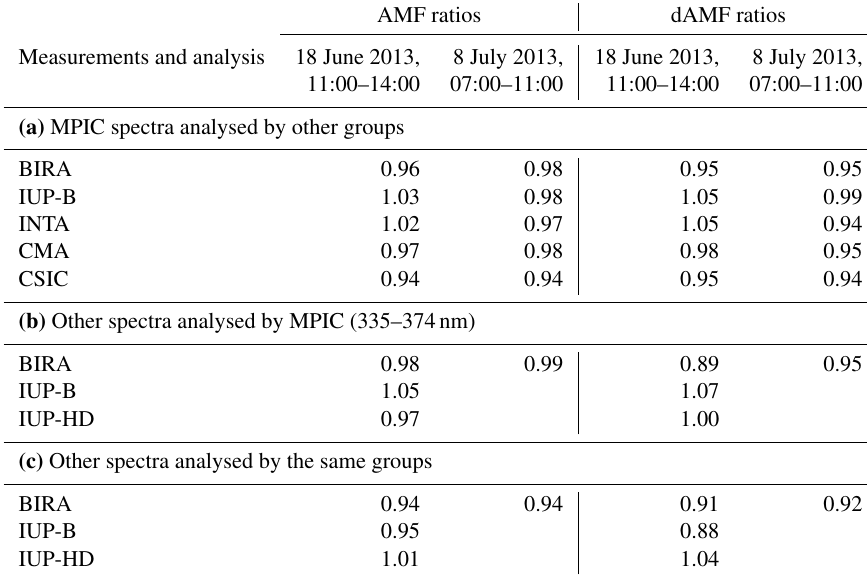
Table A25. (a) Average ratios of O 4 (d)AMFs derived from the analysis of MPIC spectra by different groups vs. the analysis of MPIC spectra by MPIC (standard analysis). (b) Average ratios of O 4 (d)AMFs derived from spectra of other groups analysed by MPIC vs. the analysis of MPIC spectra by MPIC (using the same analysis settings and spectral range: 335–374nm). (c) Average ratios of O 4 (d)AMFs derived from spectra of other groups analysed by the same groups using individual analysis settings vs. the analysis of MPIC spectra by MPIC (standard